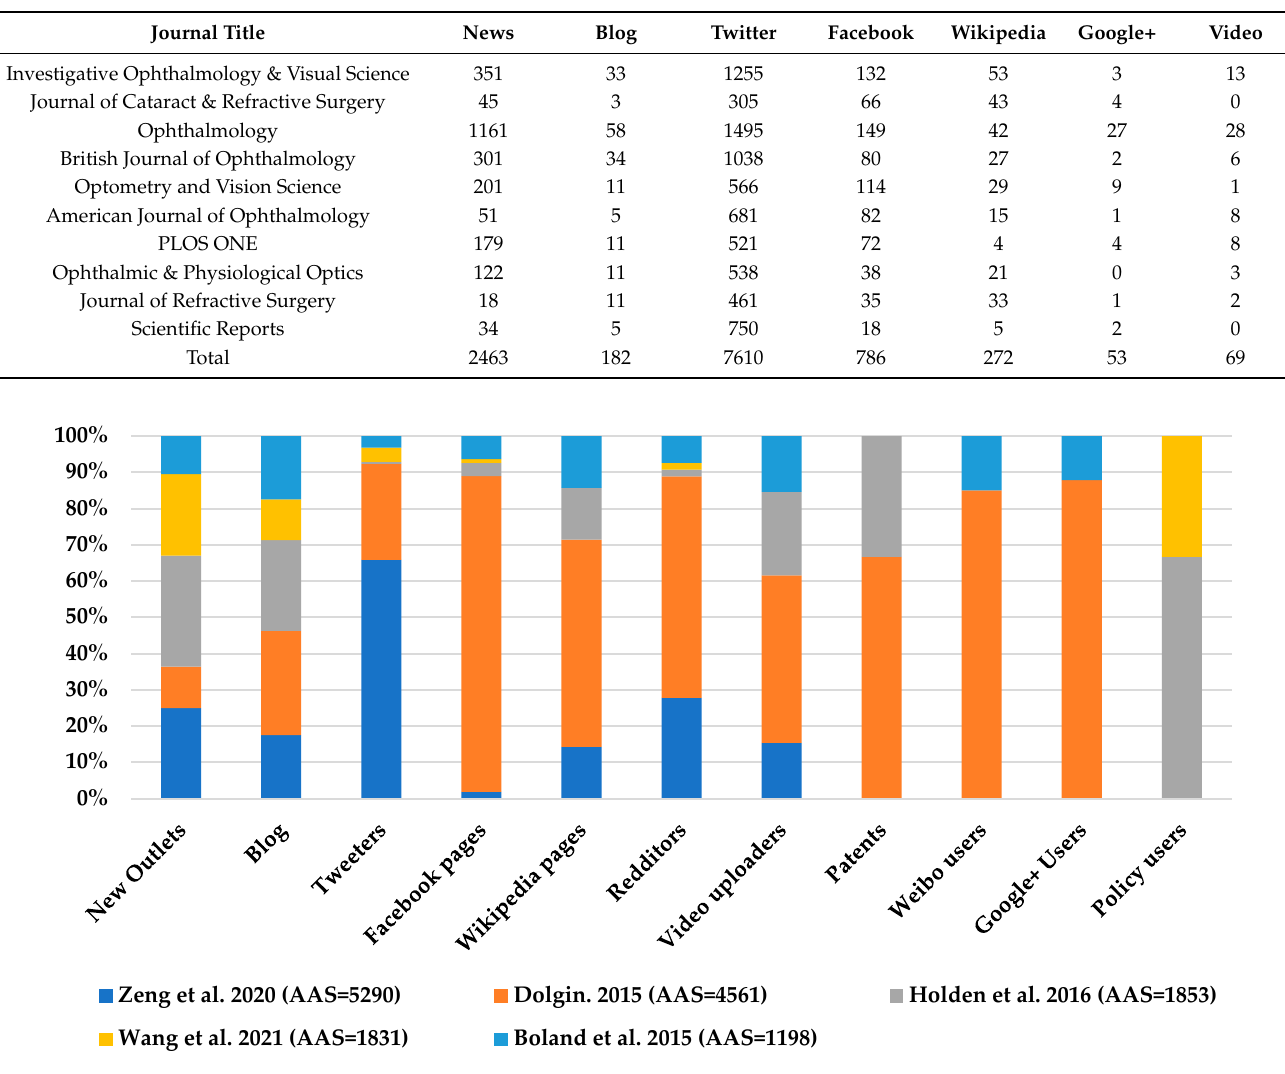
Figure 1. Overview of attention for the output of the five articles with the highest AAS (Own elaboration) [5,19–22].